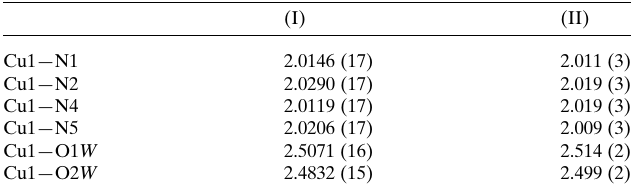
Table 1 Selected bond lengths (A˚ ).